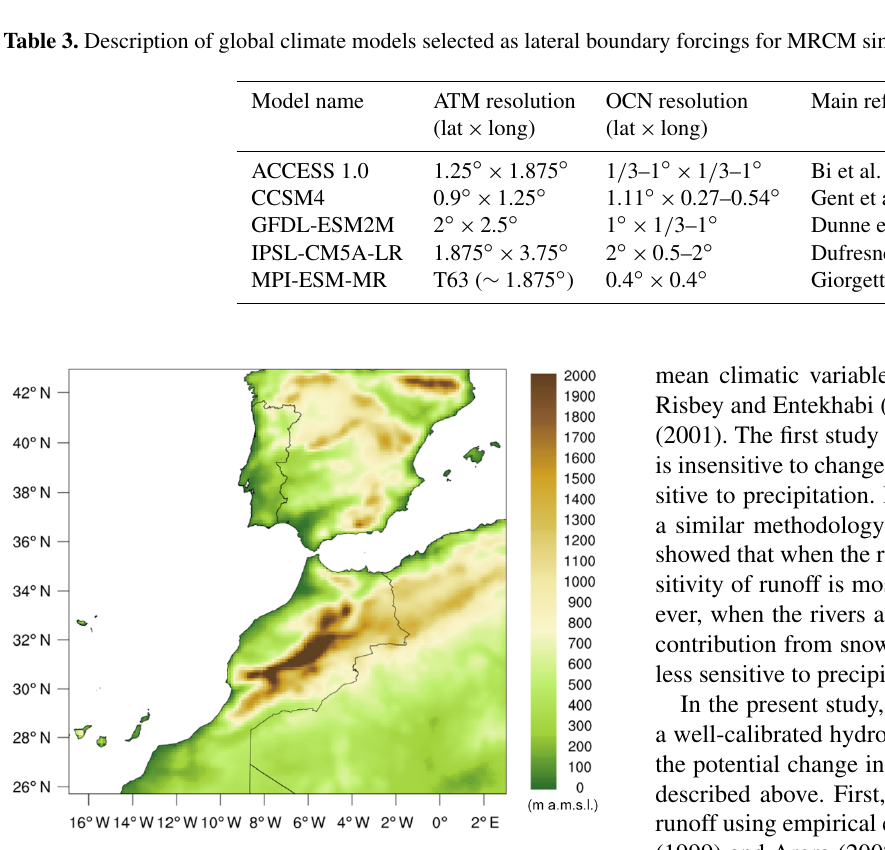
Figure 5. MRCM simulation domain and topography (in ma.m.s.l. – meters above mean sea